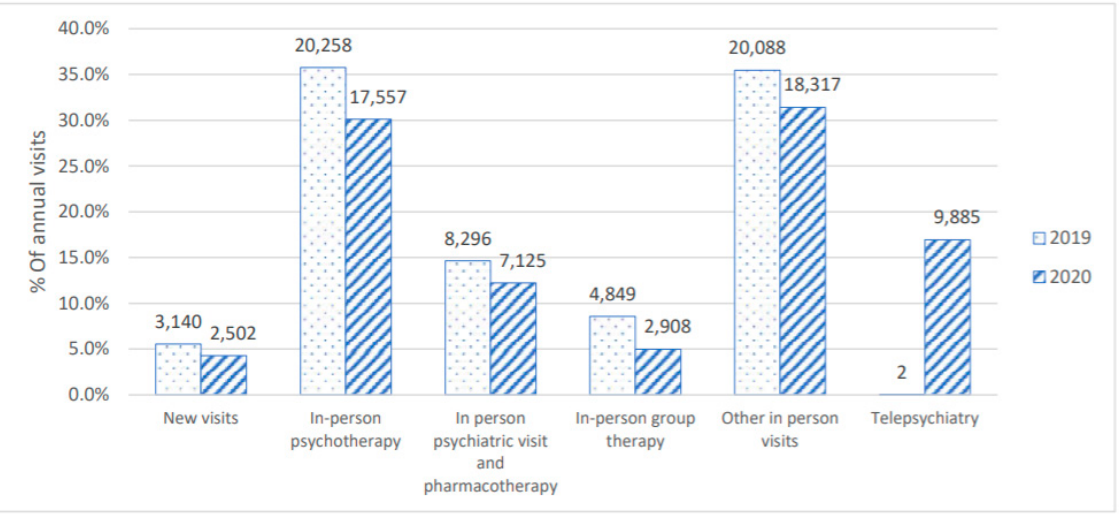
Figure 1. Annual trends in visit type and use of telepsychiatry between 2019 and 2020. Y-axis represents the percent of specific visit types out of all annual visits. Data labels represent the cumulative sum of visit types during each year. No error bars are presented due to the use of cumulative sums instead of means.